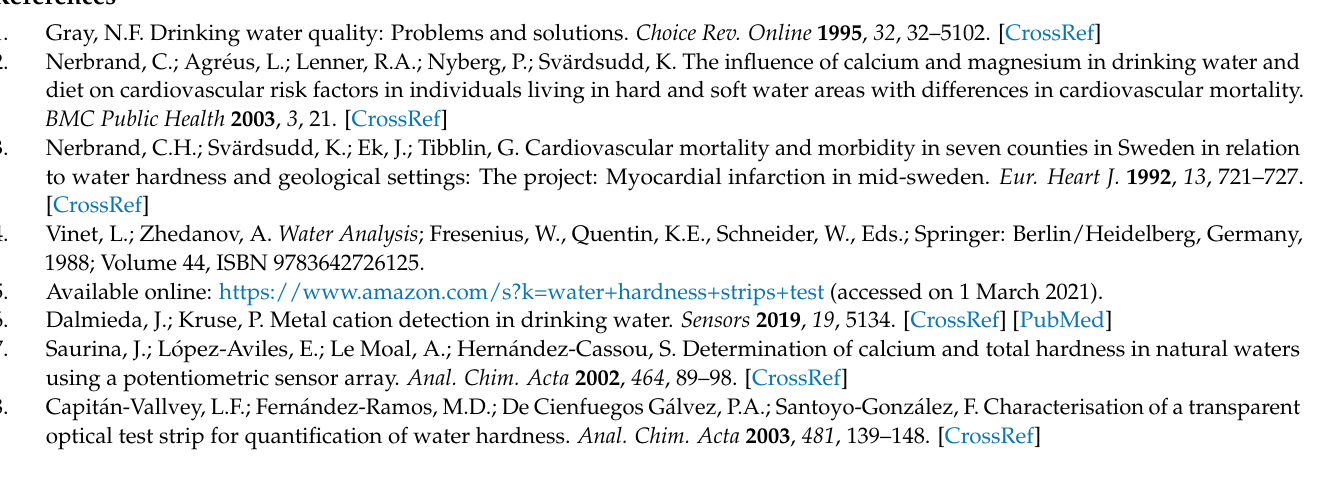
according to the total hardness. Table S2: Mg2+, Ca2+ Ion selective and reference membranes composition respectively. Table S3: Analytical parameters of calcium and magnesium paper-based ISEs in a separate calibration. Table S4: The chemical composition of the artificial water samples with chloride as counter anion. Table S5: Prediction of Ca2+ and Mg2+ in artificial water samples. Figure S1: The dilution effect on the prediction of Mg2+ and Ca2+ sensors respectively (N =